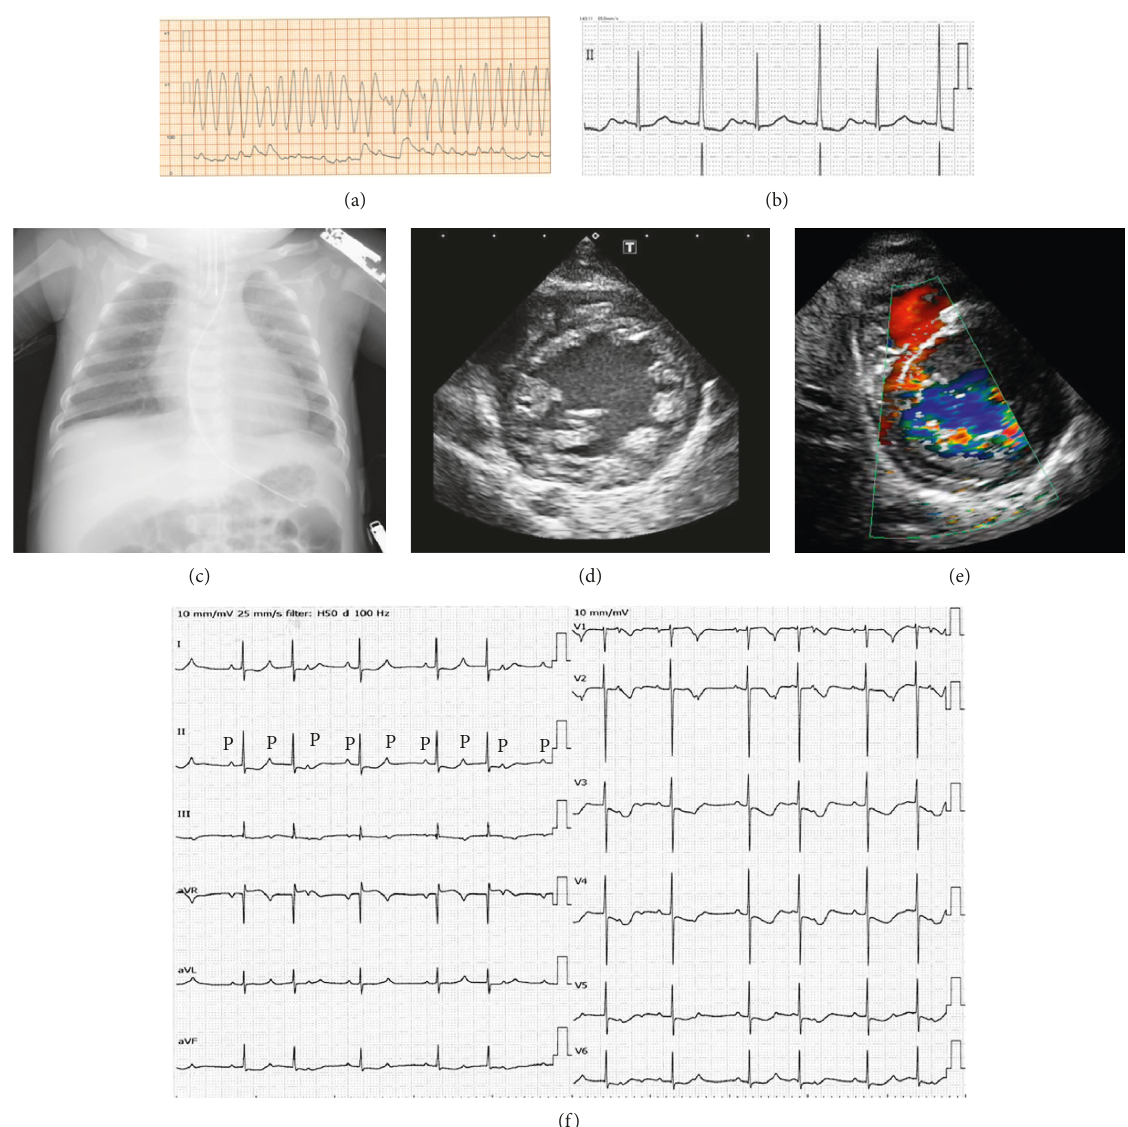
Figure 1: Electrocardiogram (ECG) and arterial blood pressure monitoring on admission (a). (Top panel) ECG shows polymorphic ventricular tachycardia, with a rate of approximately 300bpm. (Bottom panel) arterial blood pressure monitoring. (b) Lead II of the ECG after polymorphic ventricular tachycardia was stopped. The heart rate (HR) was 79 bpm, PR interval was 160msec, and QTc interval was 510msec with alternate T waves. (c) Chest X-ray on admission showing a cardiothoracic ratio of 52%. Transthoracic echocardiography on admission. (d) Transthoracic echocardiography shows left ventricular noncompaction on the parasternal short axis view, with a ratio of noncompacted to compacted area at end-systole > 2. (e) Color Doppler imaging reveals communication between myocardial recesses and the left ventricular cavity. (f) The 12-lead ECG before implantable cardioverter defibrillator (ICD) implantation, showing 2 :1 atrio- ventricular block. The HR was 76bpm, PR interval was 170 msec, and QTc interval was 462msec. P indicates the P wave in lead